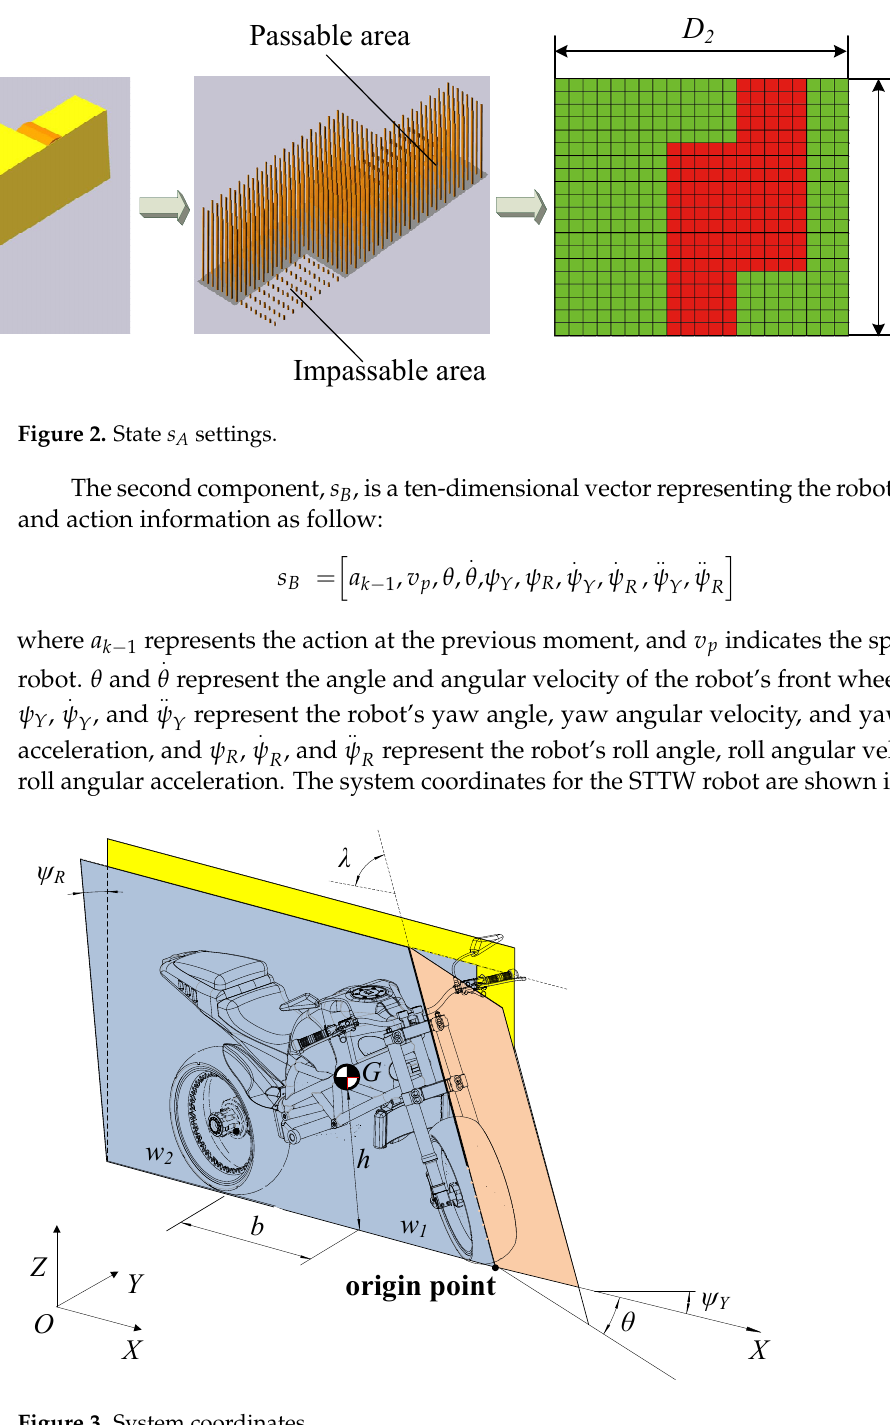
Figure 3. System